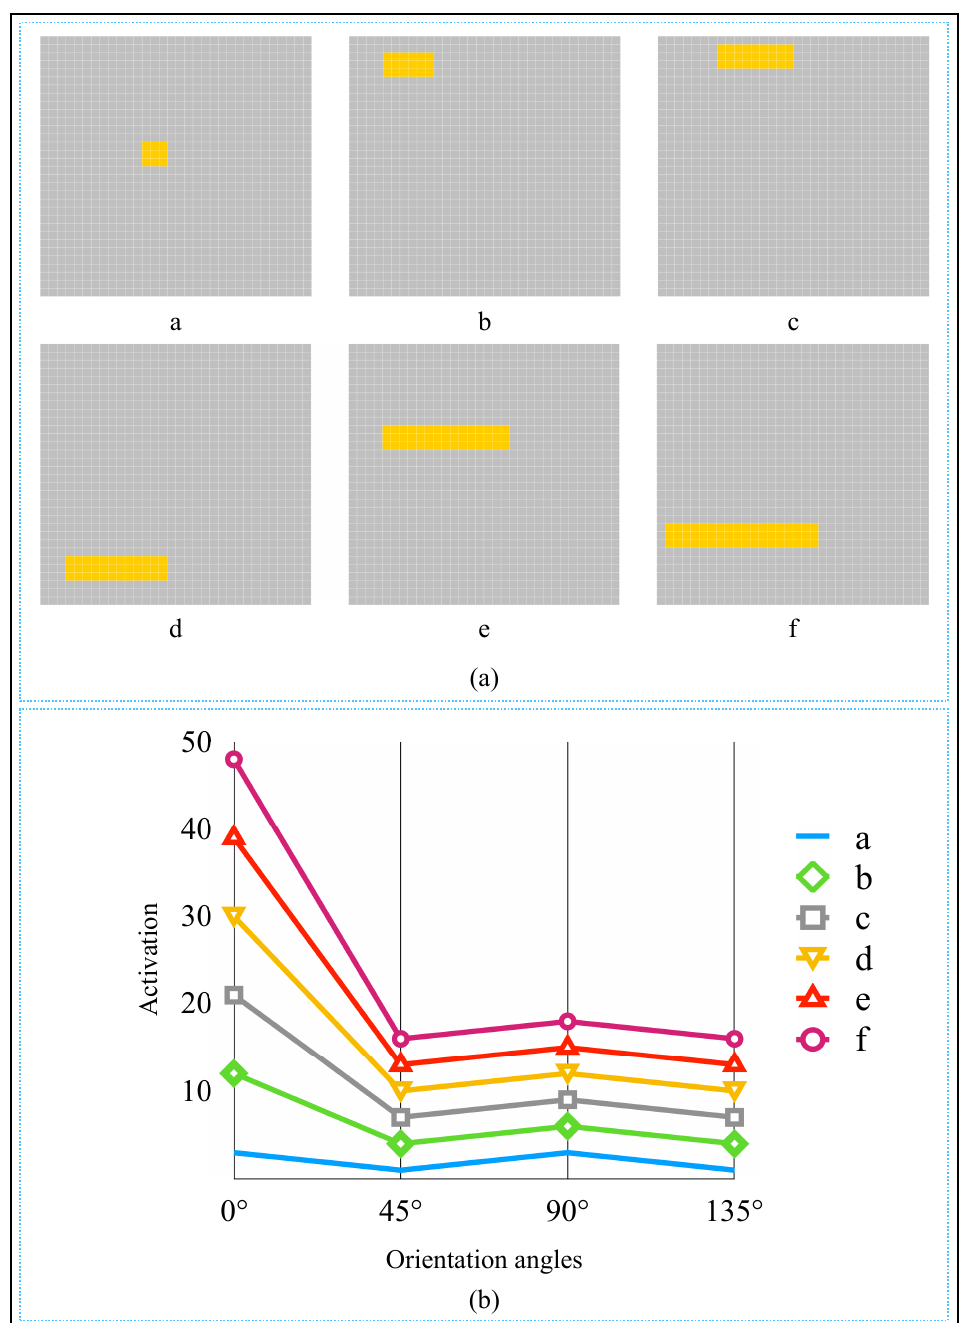
Figure 15. The detected objects and activation curves. ( a ) The objects to be detected. ( b ) Spike rate curves of complex cells on six